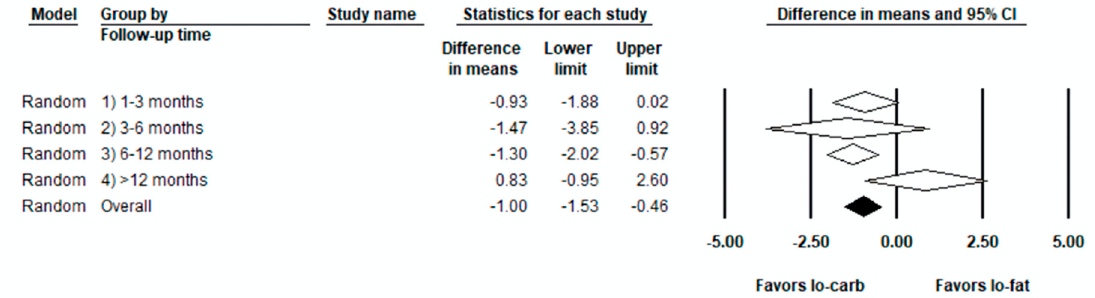
Figure 2. Forest plots showing weighted mean differences (WMD) and 95% CI across all studies and time periods for weight loss.